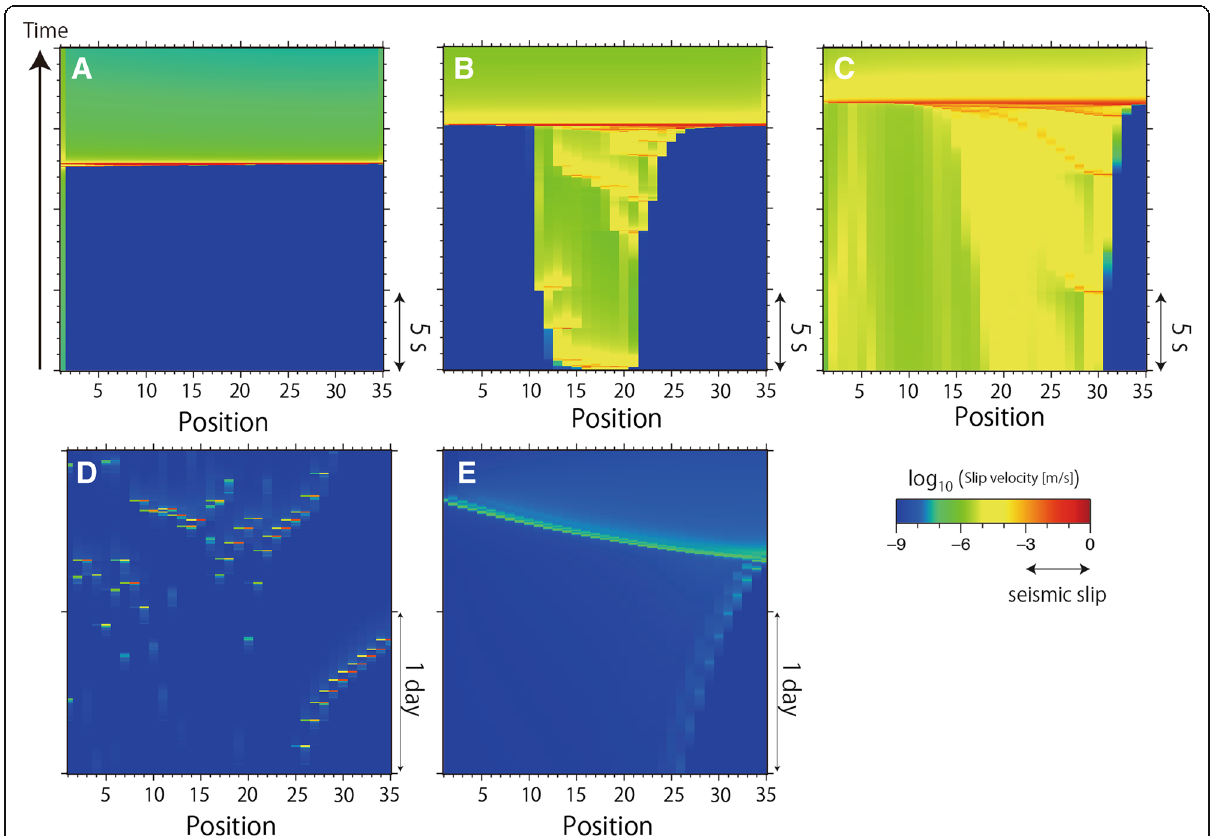
Fig. 3 Detailed slip behaviors of the fault. Five examples (parameter sets A – E in Fig. 2) are shown, one per panel. Horizontal axis shows the location (referenced by cell number) along the fault (cf. Fig. 1). Time flows from bottom to top on the vertical axis. Color intensity corresponds to slip velocity in each cell as a function of time